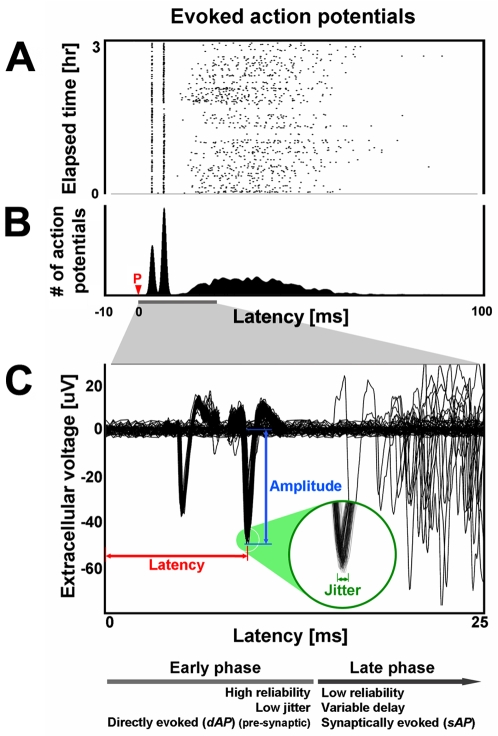
Electrically evoked neural activity.Action potentials recorded on one extracellular electrode in response to stimulation at another consist of an early directly-evoked action potential (dAP) phase and a later synaptically-evoked action potential (sAP) phase. (A) The raster plot (1 dot per action potential) shows the first 100 ms of neural responses to 3 hours of periodic 1/2 Hz probe stimulation (red P). (B) The peri-stimulus time histogram and (C) overlaid extracellular voltage traces across all trials emphasize the consistency of the early phase with respect to the later phase. The sharp peaks in the histogram arise from two dAPs. See also [26].